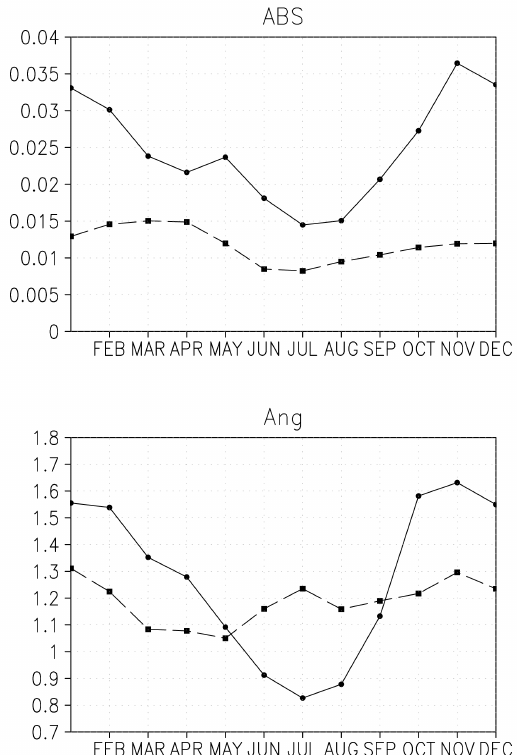
Fig. 11. Monthly mean (a) absorption AOD and (b) Angstrom pa- rameter for China (dashed line) and India (solid line), four-year av- erage